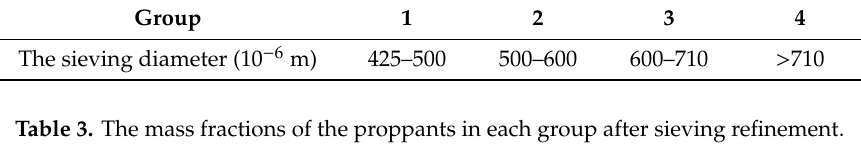
Table 3. The mass fractions of the proppants in each group after sieving refinement.